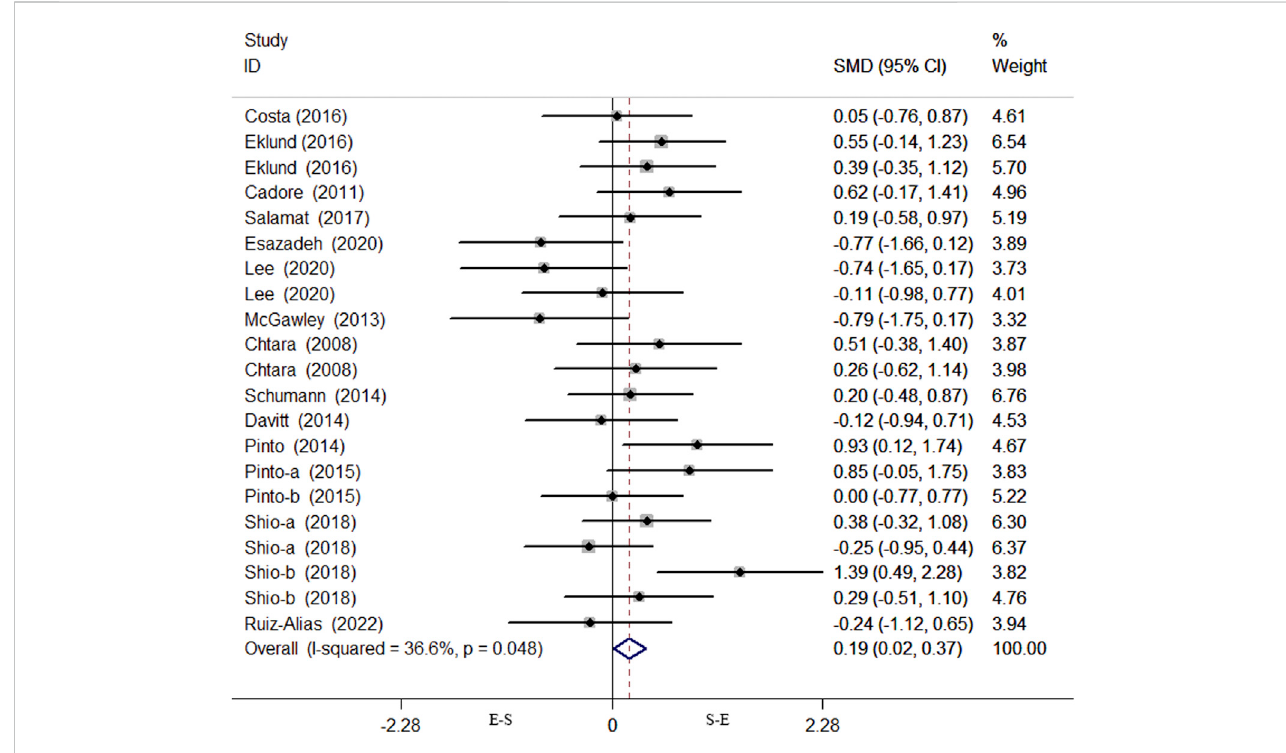
FIGURE 5 Forest plot of effects of concurrent training sequence on lower limb